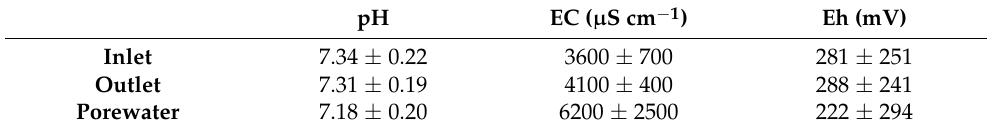
Table 1. The 16 week mean values ( ± standard deviation) for pH, electrical conductivity (EC), and redox potential (Eh) measured in wetland inlet, outlet ( n = 16), and porewaters ( n = 60–80). pH EC ( µ S cm − 1 ) Eh (mV) Inlet 7.34 ± 0.22 Outlet 7.31 ± 0.19 288 ± 241 Porewater 7.18 ± 0.20 6200 ± 2500 222 ±